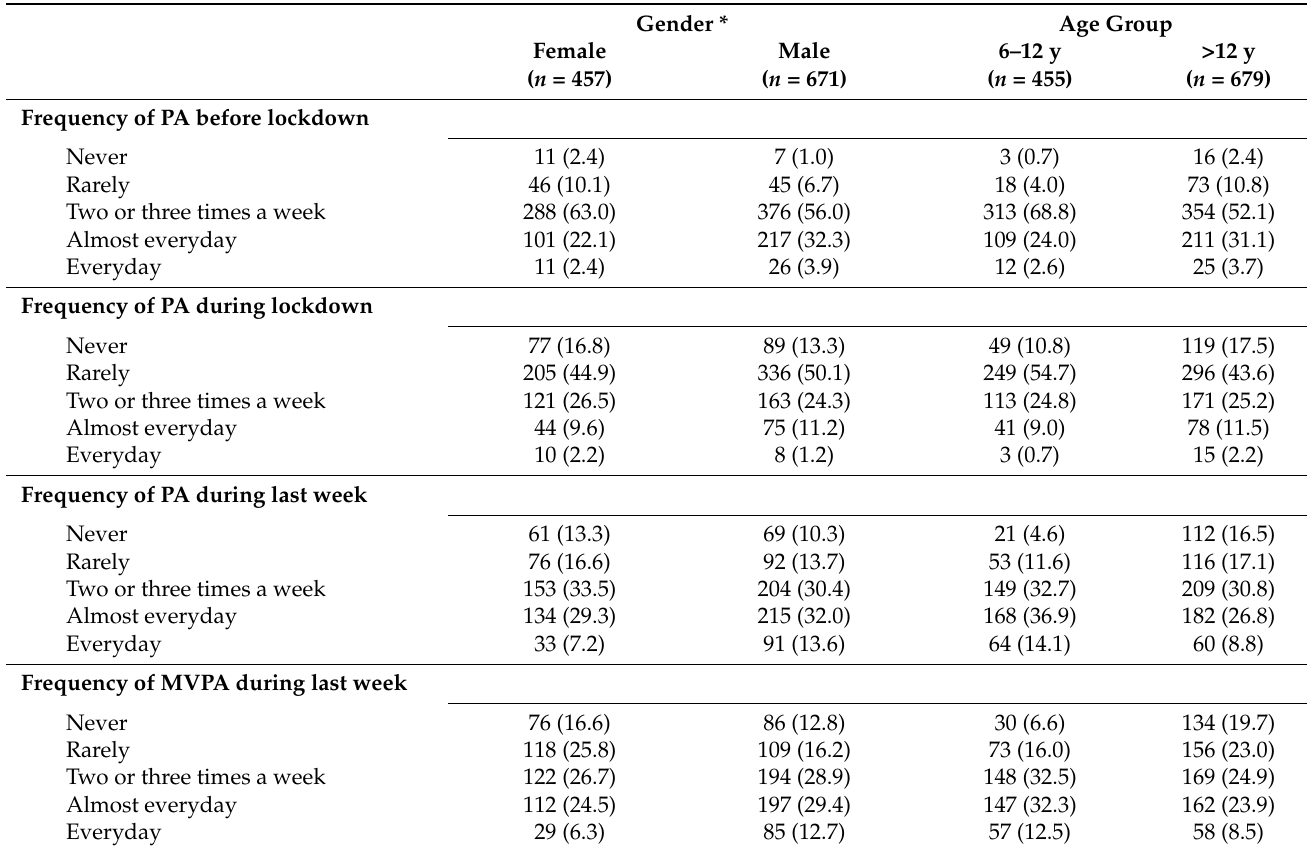
Table 2. Answers to questionnaire items, by gender and by age group ( n = 1134)—Metropolitan city of Bologna (2021). Values are counts (percentages).